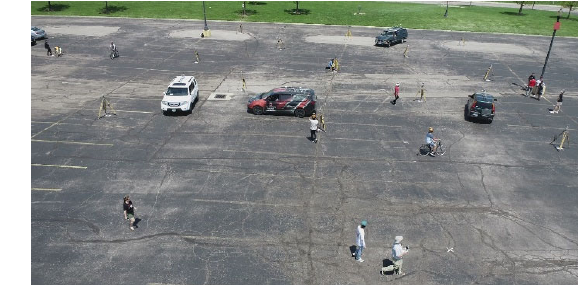
Figure 2. Test are with ground